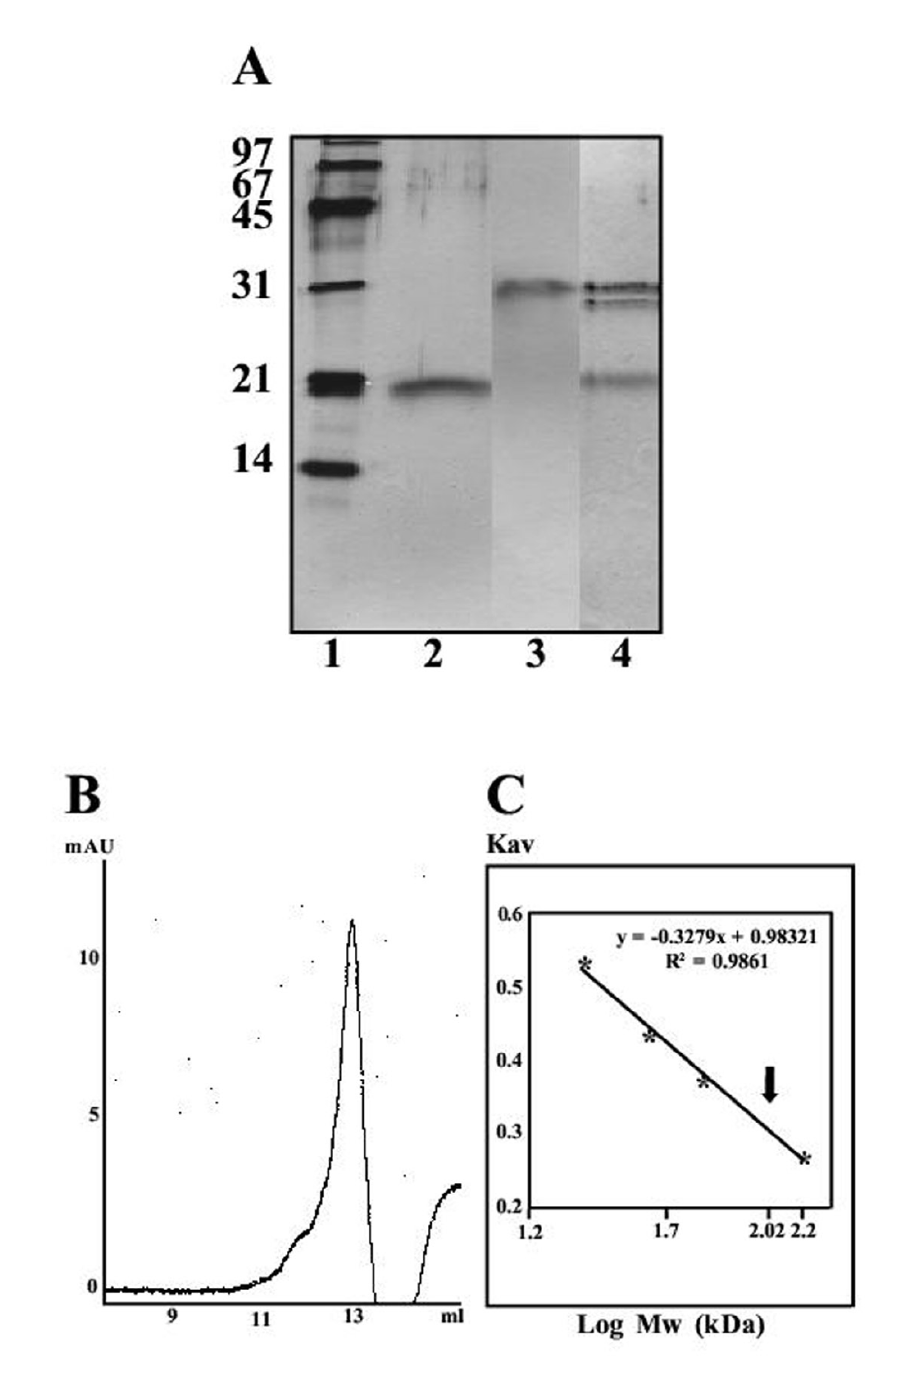
Figure 4 MP20/galectin-3 complex formation in vitro . (A) SDS-PAGE analysis of pure MP20 and pure galectin-3 and of the com- plex formed. Lane 1 . Molecular weight markers. Lanes 2 and 3 . Pure MP20 and galectin-3 used for the binding experiment, respectively. Lane 4 . The complex eluted from the gel filtration column. Galectin-3 appears as a doublet due to minor proteol- ysis [28]. (B) Size exclusion chromatography of MP20/galectin-3 complexes formed following the mixing of purified lens MP20 with purified galectin-3. The complex eluted at 13 ml. mAU refers to absorbance units at 280 nm. (C) Calibration of the S-200 column. V o = 7.8 ml. MP20/galectin-3 complex has an apparent molecular mass of 104 kDa